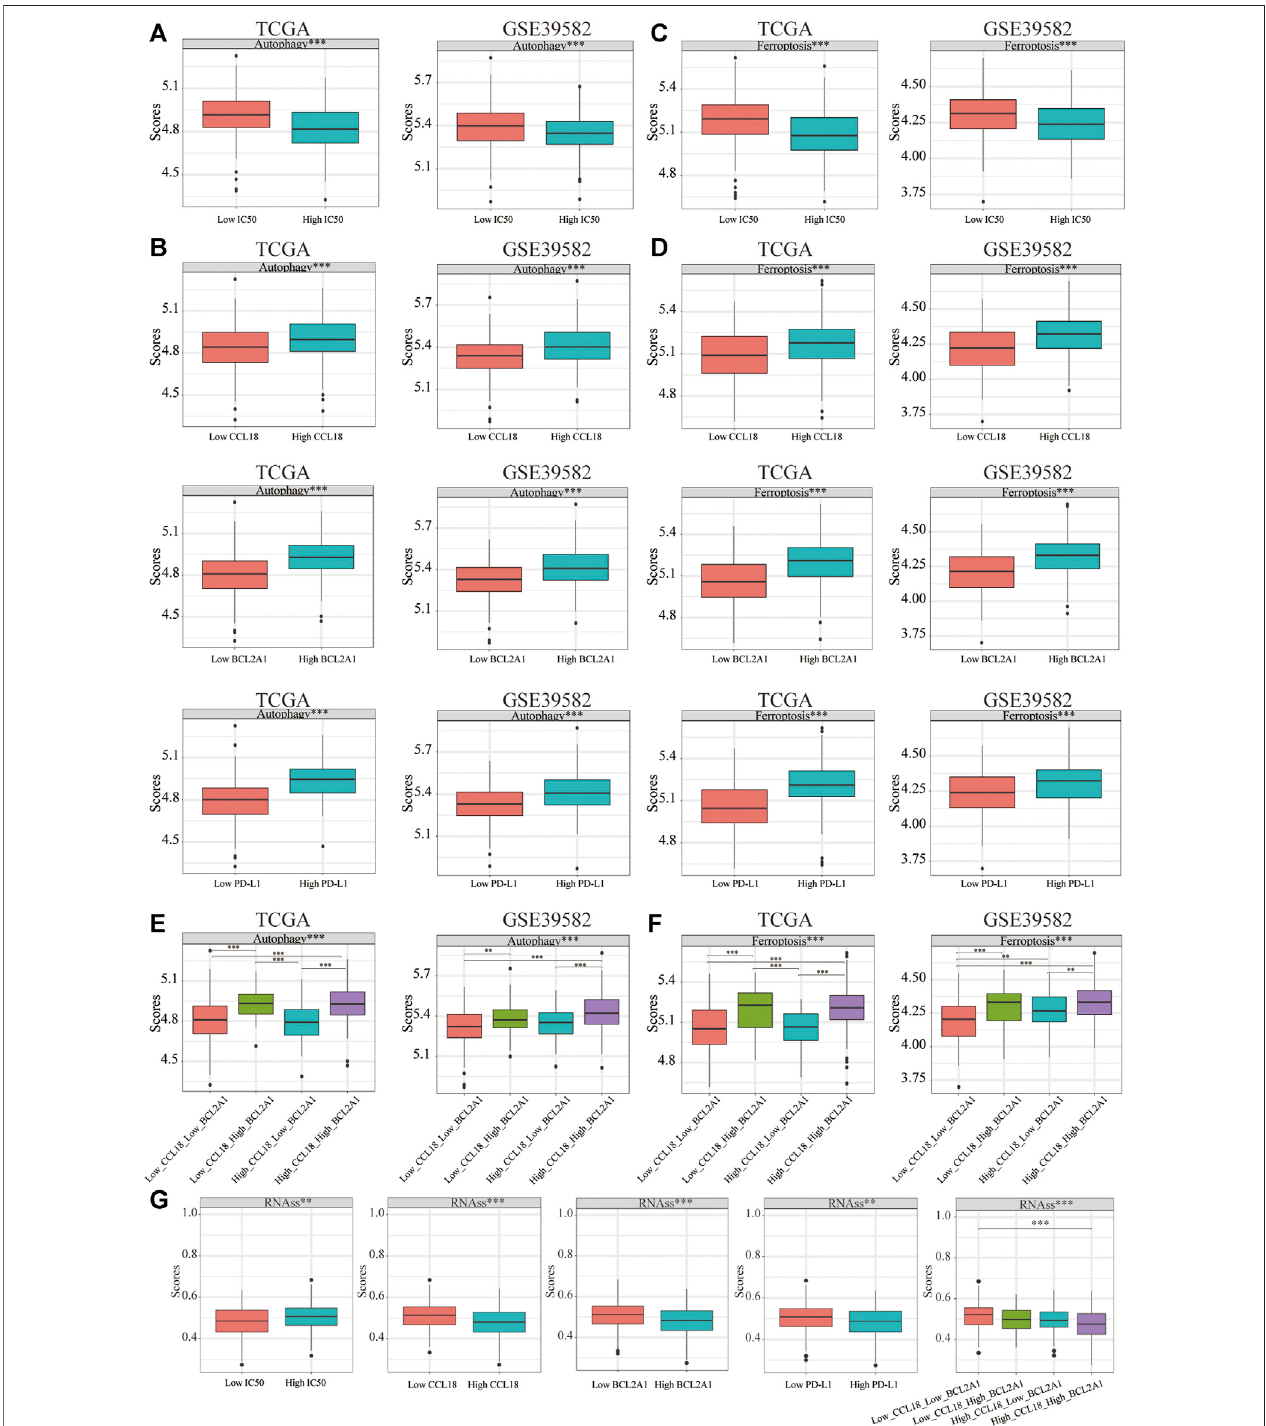
FIGURE11| Thedifferenceofautophagy,ferroptosis,andstemnessscores.InTCGAandGSE39582,theautophagyscoreof (A) thelow-IC50groupand (B) high group ofCCL18orBCL2A1orPD-L1 weresigni fi cantlyhigher.Similarly,forferroptosis,thescoreof (C) thelow-IC50 groupand (D) high groupofCCL18orBCL2A1or PD-L1 were signi fi cantly higher. (E , F) The autophagy or ferroptosis score of High_CCL18_High_BCL2A1 patients were signi fi cantly higher than that of Low_CCL18_Low_BCL2A1 and High_CCL18_Low_BCL2A1 patients. The autophagy or ferroptosis score of Low_CCL18_High_BCL2A1 patients were signi fi cantlyhigher than that ofLow_CCL18_Low_BCL2A1 patients. (G) The stemnessscore ofthe lowIC50 group and high group ofCCL18or BCL2A1or PD-L1 was signi fi cantly upregulated. The stemness score of High_CCL18_High_BCL2A1 patients was signi fi cantly upregulated than that of Low_CCL18_Low_BCL2A1 patients. ** p < .01, *** p < .001.